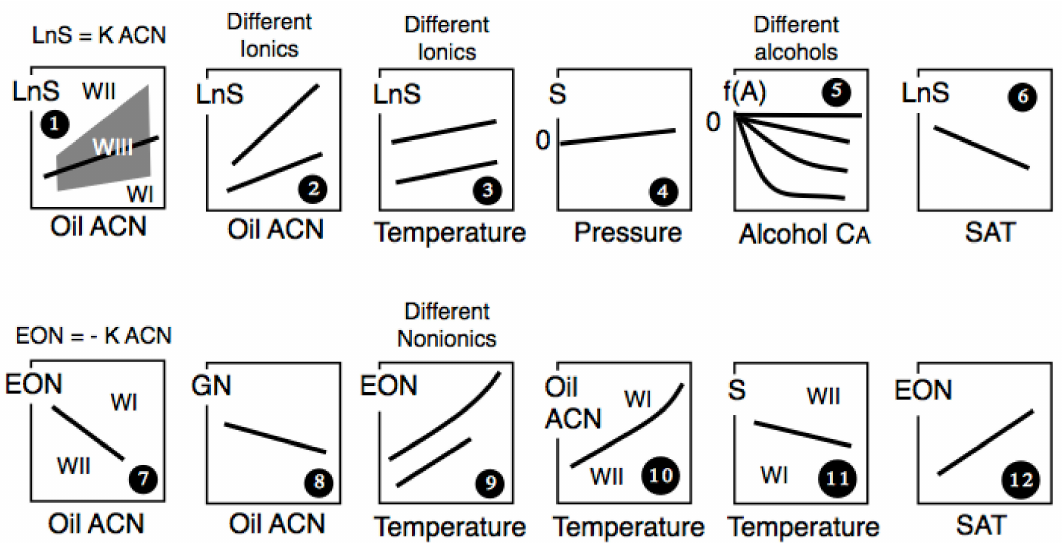
Figure 10. Aspects of a typical (LnS vs ACN) bidimensional scan and other similar cases involving two formulation variables (EON: surfactant ethylene oxide number, GN: surfactant glycerol number, SAT: surfactant alkyl tail carbon number, C A : alcohol concentration, f(A) = K A C A : alcohol e ff